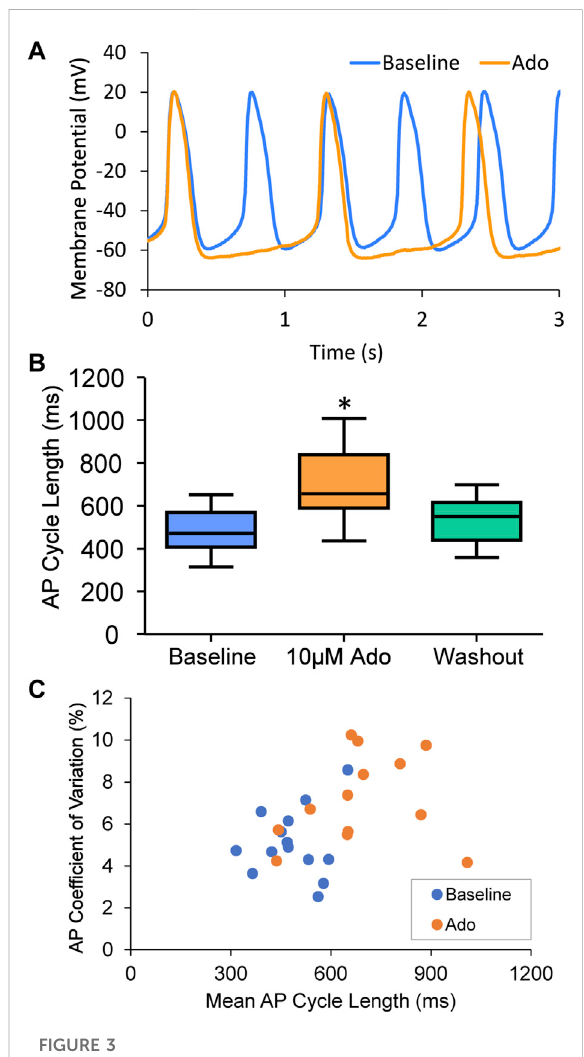
(Figure 9C). Therefore, the APCL depends on the LCR period (Figure 9B) and that relationship informs on the fi delity of clock coupling: with ado, the clock coupling, re fl ected in the LCR period, was